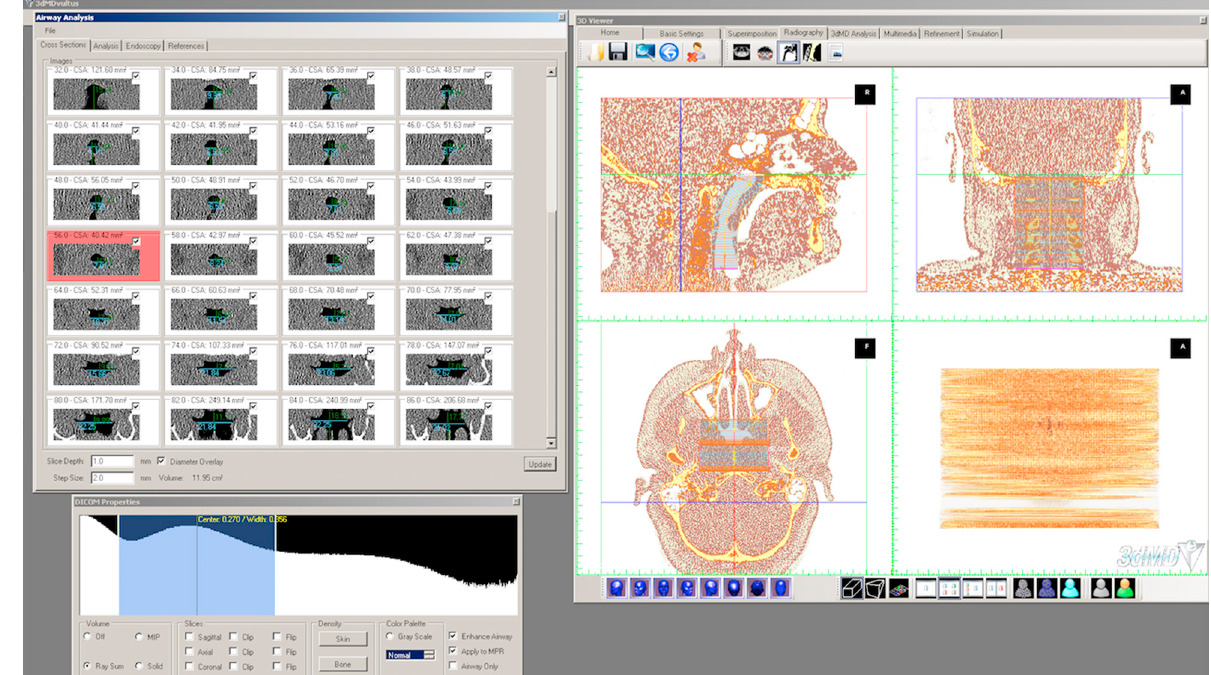
Figure 2. 3D Measurements (3dMDVultus software, 3dMD, Atlanta,